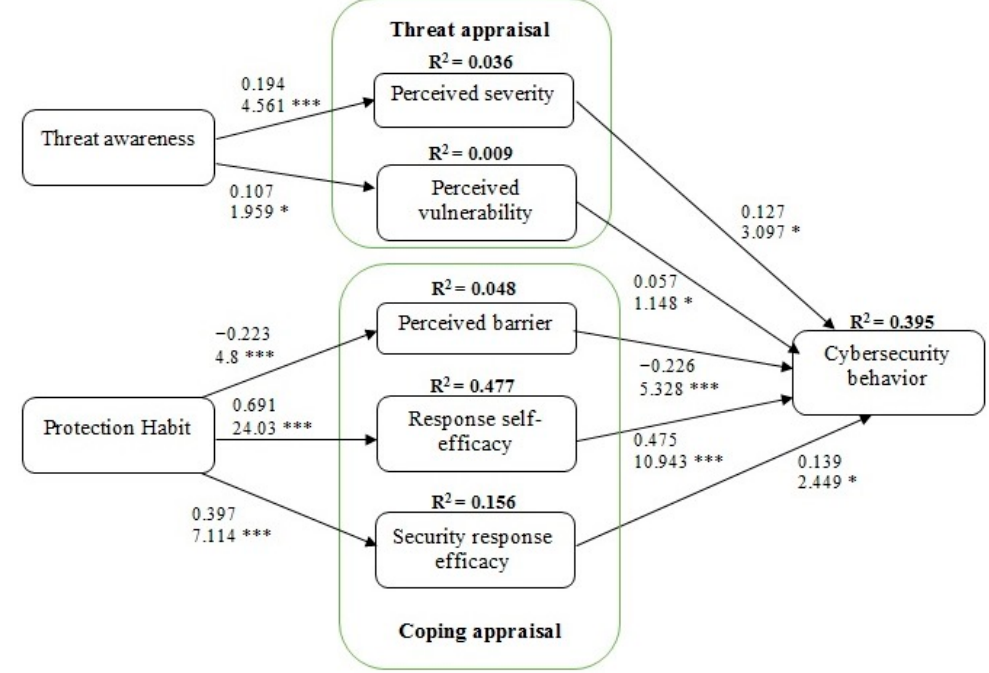
Figure 3. Results of the structural model. Note: * p < 0.05; *** p < 0.001. Table 5. Summary of the structural model.